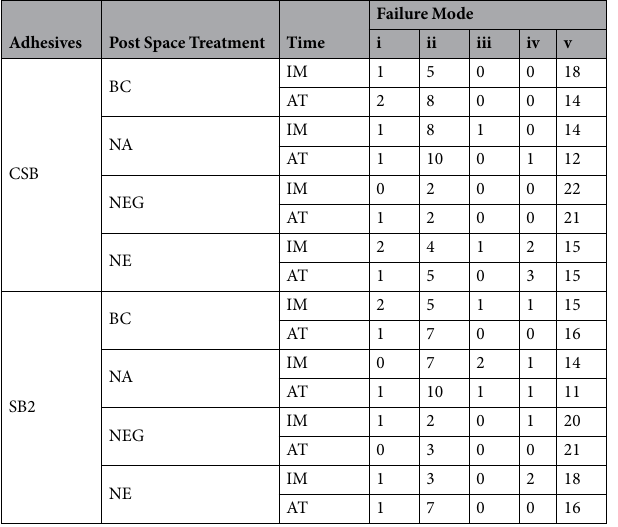
Table 2. Distribution of failure mode (n = 24). IM, immediate; AT, after thermocycling. Failure mode: (i) adhesive failure between post and cement; (ii) adhesive failure between dentin and cement; (iii) cohesive failure within cement; (iv) cohesive failure within dentin; and (v) mixed